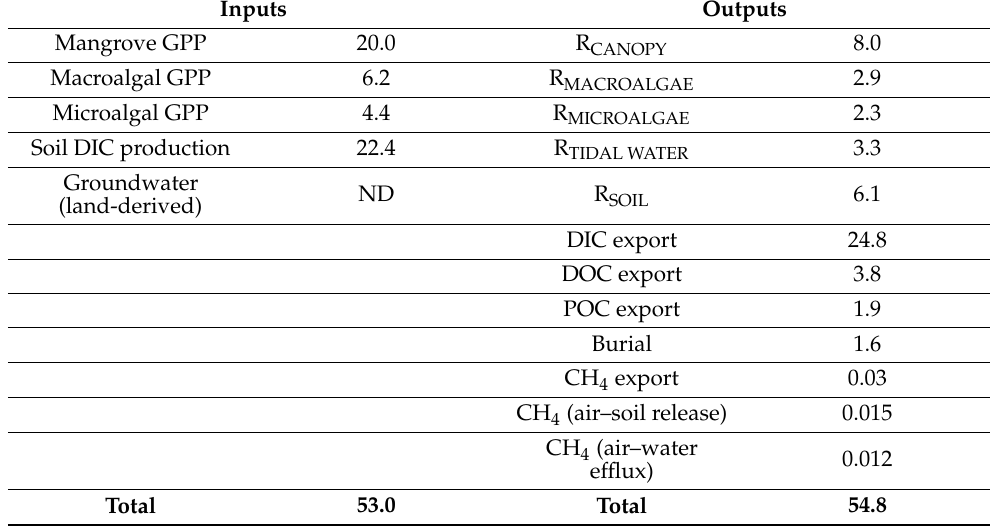
Table 5. Blue carbon mass balance in an undisturbed mangrove forest (Mg C ha − 1 a − 1 ) based on globally averaged data from Figure 2 and reference [76]. Abbreviations: GPP = gross primary production; R CANOPY = forest canopy respiration; R MICROALGAE = benthic microalgal respiration; R TIDAL WATER = pelagic respiration; R SOIL = benthic respiration (CO 2 air + DIC water); ND = no